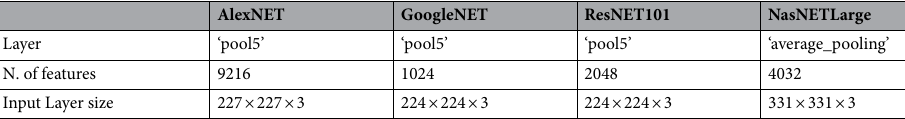
Table 8. Lists of deep learning architectures selected for the test: layers used and total number of features